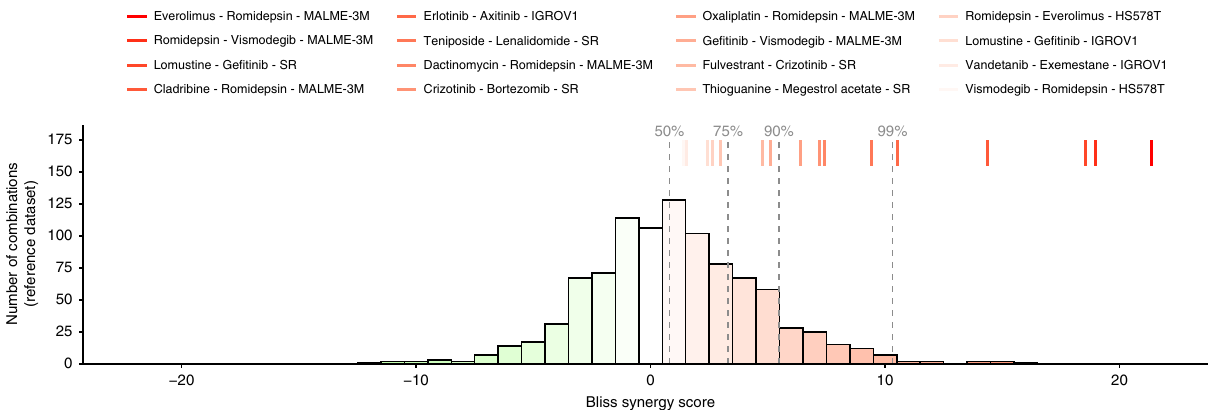
Fig. 4 Measured drug combination synergy scores in the experimental validation. In-house experimental validation of 16 selected predictions in speci fi c cell lines are shown as colored lines (on top), and the histogram shows a background distribution from in-house reference dataset that comprises of 60 drug combinations tested against 16 KRAS-mutants pancreatic ductal adenocarcinoma cell lines (see “ Methods ” ). The synergy was quanti fi ed using Bliss independence score for the most synergistic area of the dose – response matrix (see Supplementary Fig. 9 for other synergy scores). The color scale corresponds to the Bliss scores (green — antagonistic response, white — independent response, red — synergistic response). Dashed lines denote the percentiles of the background distribution obtained using the same experimental